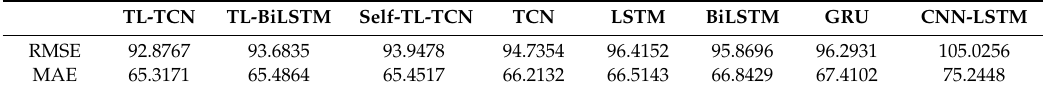
Table 13. Air quality prediction results with daily sampling interval.